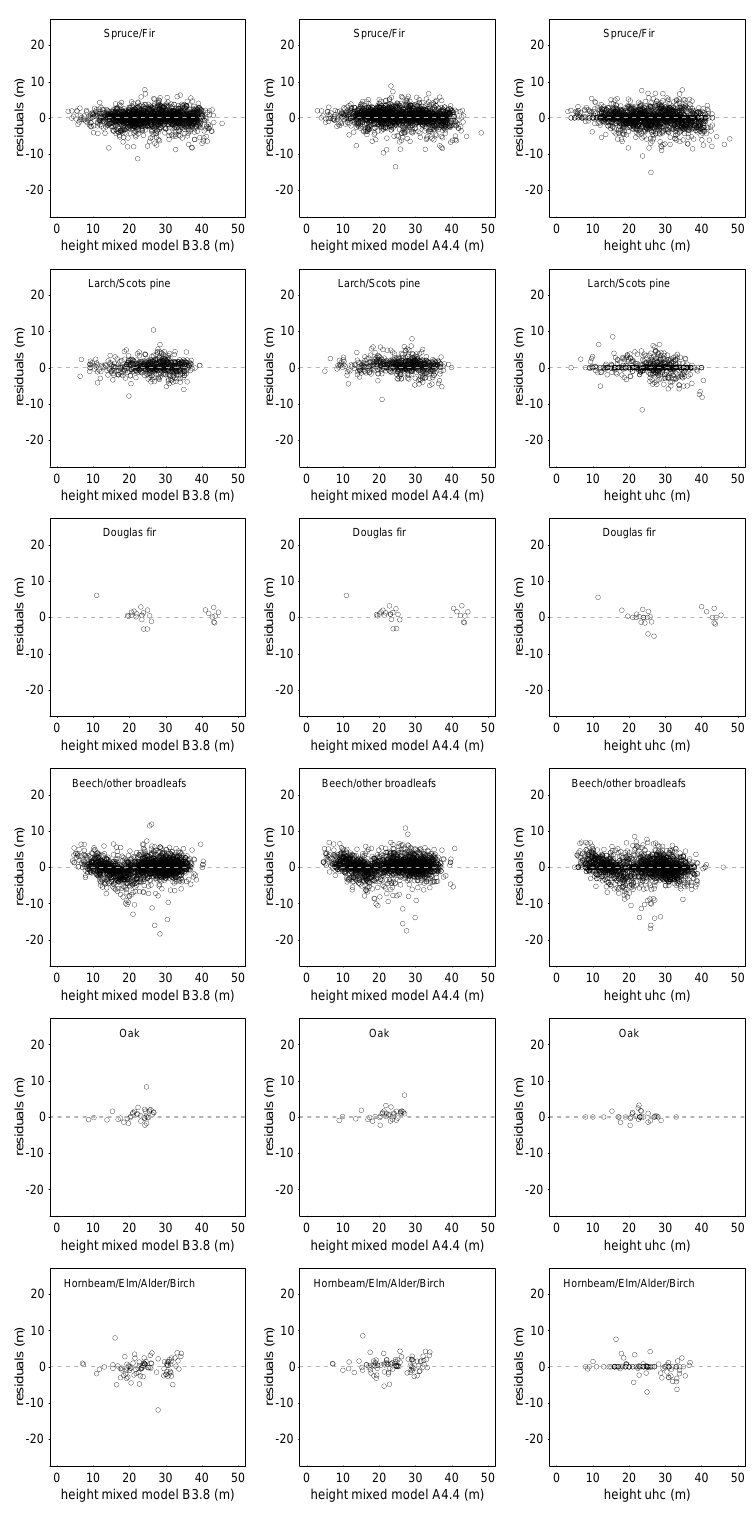
Figure A3. Residuals against predicted heights.